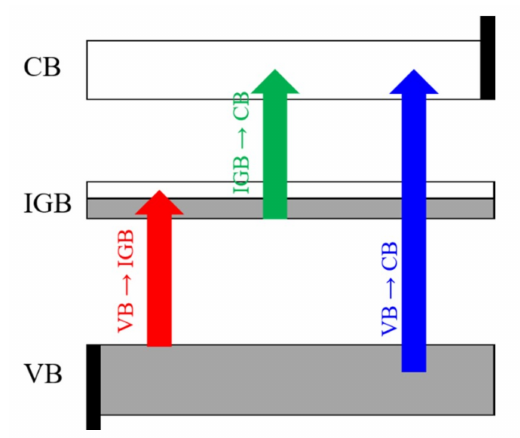
Figure 1. The IGB principle: photons of di ff erent energies promoted electrons VB to CB (VB → CB), as well as VB → IGB and IGB → CB, widening the photon range